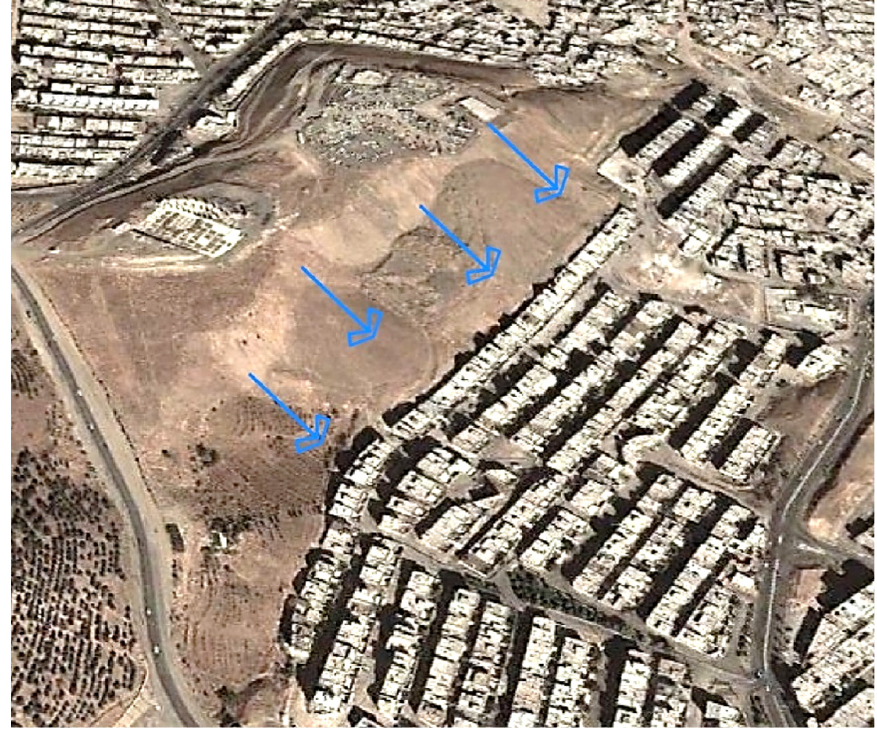
Figure 3. Streets perpendicular to the general direction of earth slope.